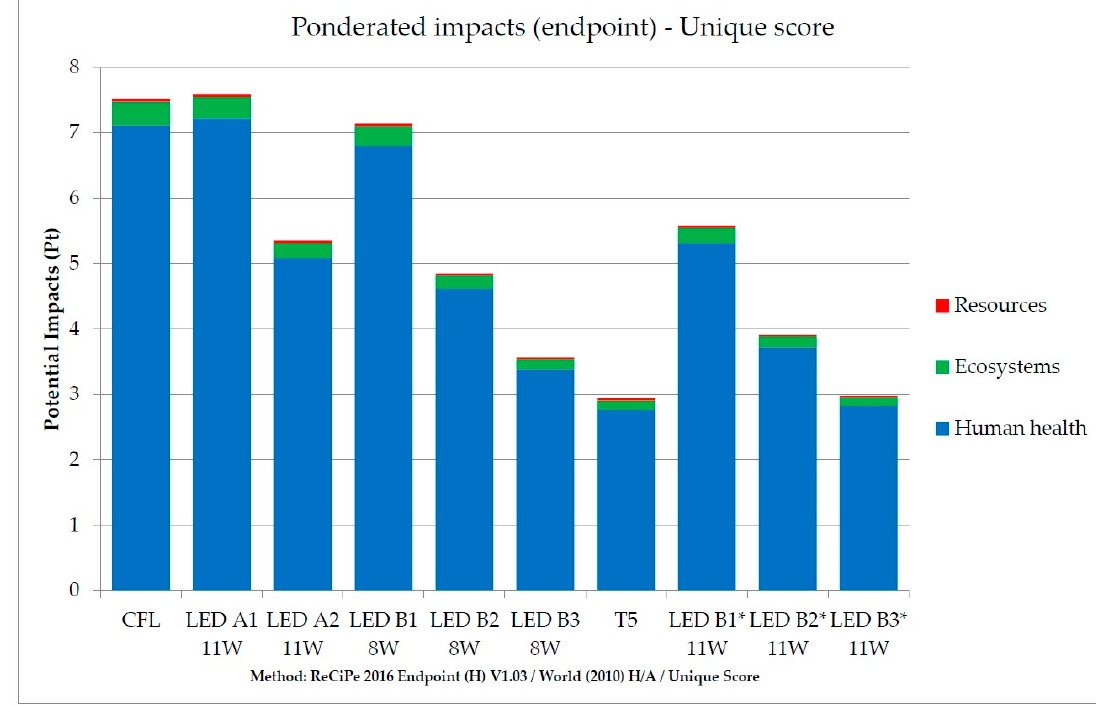
Figure 10. Endpoint potential impacts of lighting systems (new building or refurbishment scenario).